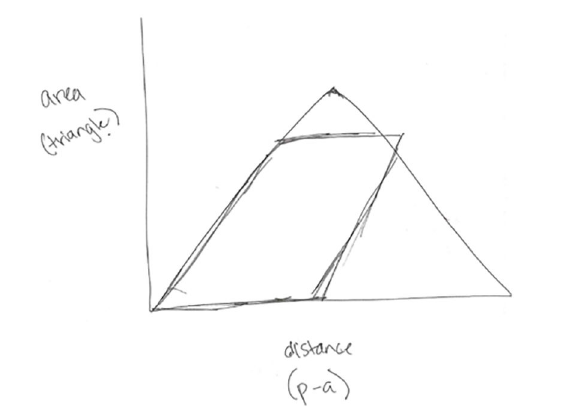
Figure 7. Olivia’s graph comparing the triangle’s area to the distance between P and A.